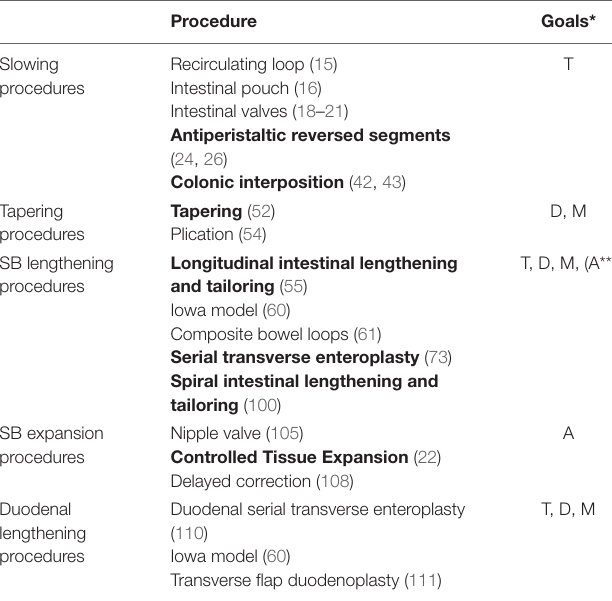
TABLE 1 | Autologous intestinal reconstruction surgery (AIRS)